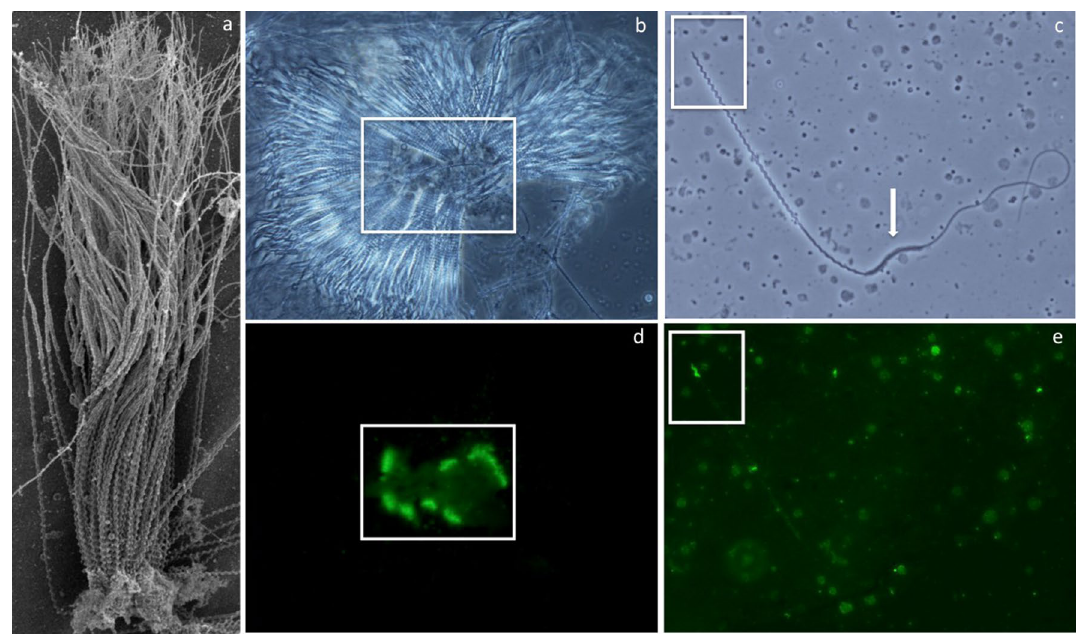
Figure 1. Whitespotted bamboo shark Chiloscyllium plagiosum spermatozuegmata and spermatozoa micrographs illustrating the morphology and acrosome location for aggregated and individual spermatozoa. Scanning electron micrograph of a spermatozeugma fragment ( a ) revealing sperm with heads closely aligned and embedded in a matrix core. Matching phase contrast and fluorescent micrographs of a spermatozeugma with radially aligned heads ( b , d ) and individual spermatozoan ( c , e ) with acrosomes highlighted by fluorescein isothiocyanate conjugated Arachis hypogaea agglutinin (PNA-FITC) stain. Whitespotted bamboo shark